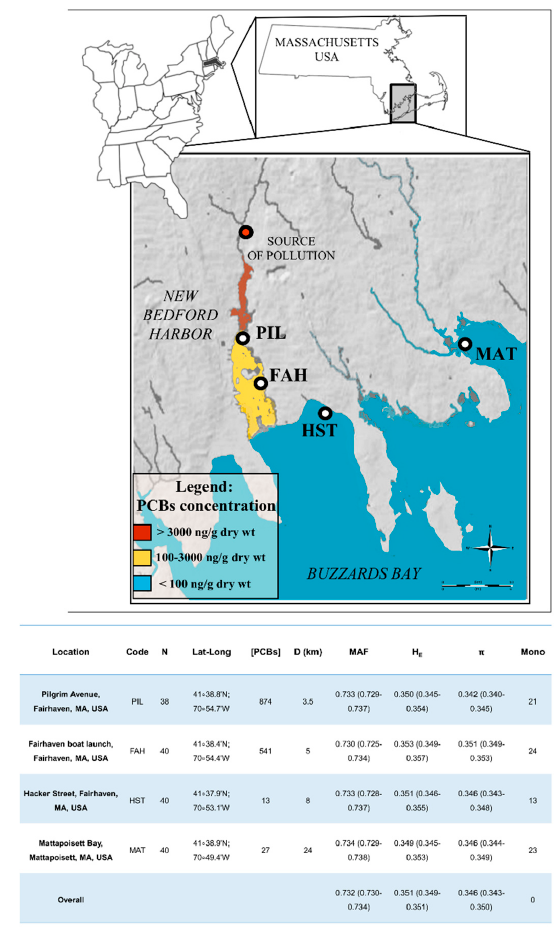
Figure 4. Geographical area and the sampling locations covered by this study. The main map refers to New Bedford Harbor and Buzzards Bay (URL: http://mapmaker.education.nationalgeographic.org). The colored coastal areas refer to the pollution gradient described in the figure legend. Map ruler (URL: https://upload.wikimedia.org/wikipedia/commons/1/1a/Scale_kilometres_miles.svg) and compass